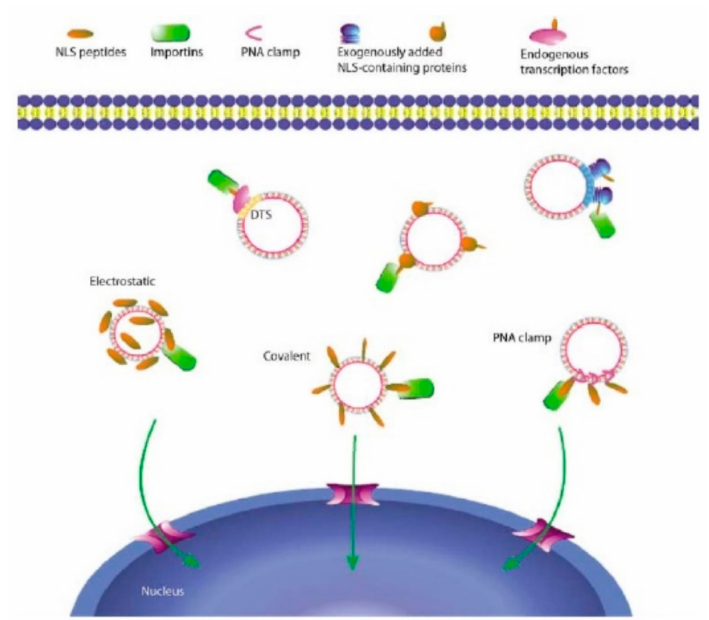
Figure 6. Various methods to enhance nuclear localization [64] (Reprinted by permission from Springer Nature and Copyright Clearance Center: Springer Nature, Gene Therapy, Nuclear entry of nonviral vectors, D A Dean et al.